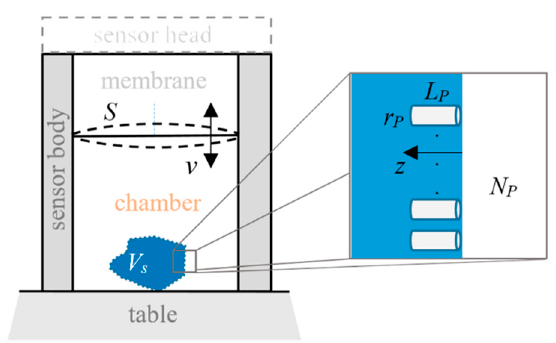
Figure 4. Measurement of an object (schematic view) with volume V S and with N p pores on its surface. L p and r p reflect the pores’ lengths and radius, respectively. v is the speed of the excitation membrane with surface S .